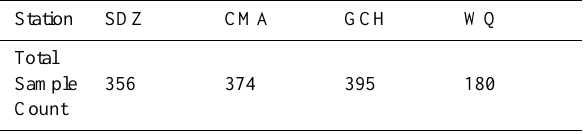
Table 2. SO 2 noontime peak occurrence frequency and the frac- tion of noontime peaks caused by (a) down-mixing due to PBL pro- cesses, (b) plume transport, (c) mountain valley breezes, and (d) fog, or severe haze